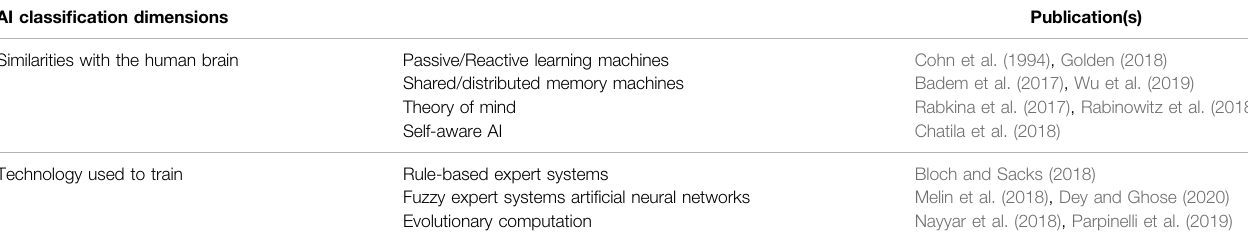
TABLE 1 | State of the art AI classi fi cation dimensions. Source: own compilation of literature review fi ndings. AI classi fi cation